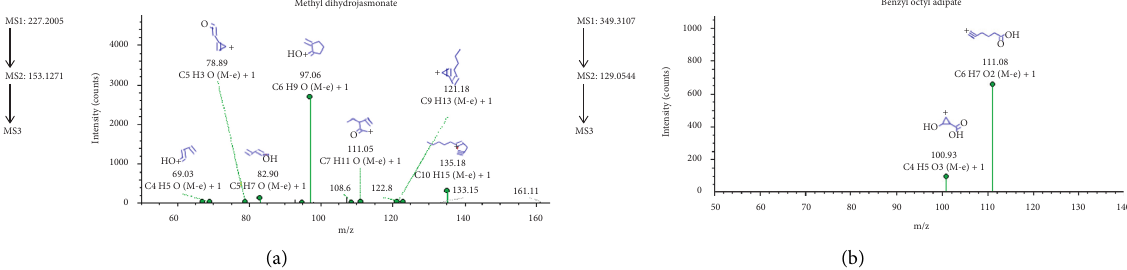
Figure 3: Experimental MS 3 spectra for methyl dihydrojasmonate and benzyl octyl adipate. The structures highlight the experimental MS 3 signals which matched with the in silico fragments obtained using Compound